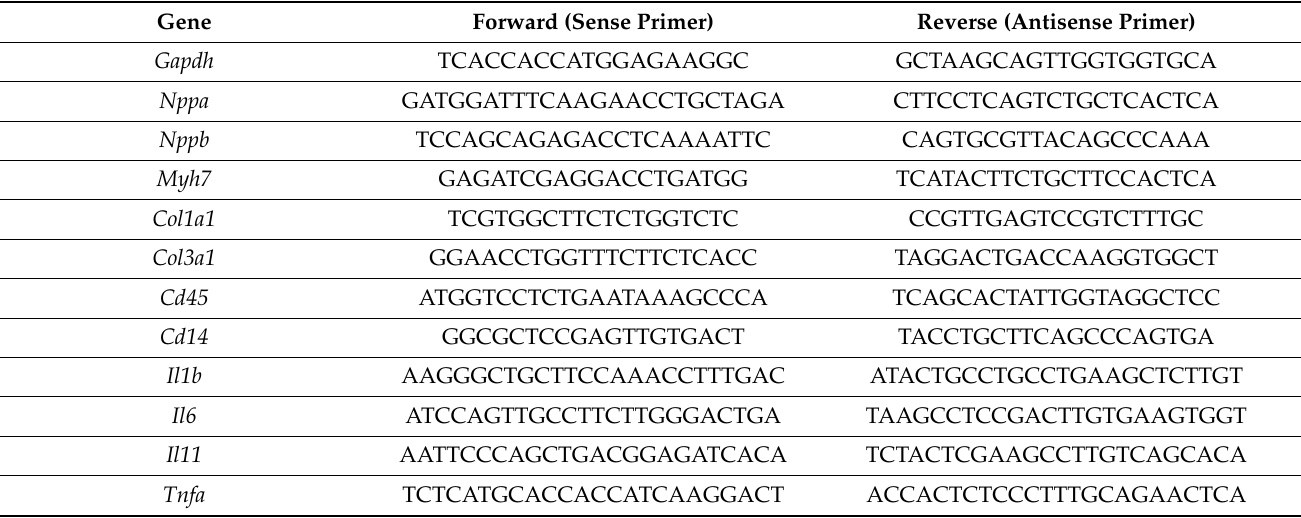
Table A2. Mouse primer